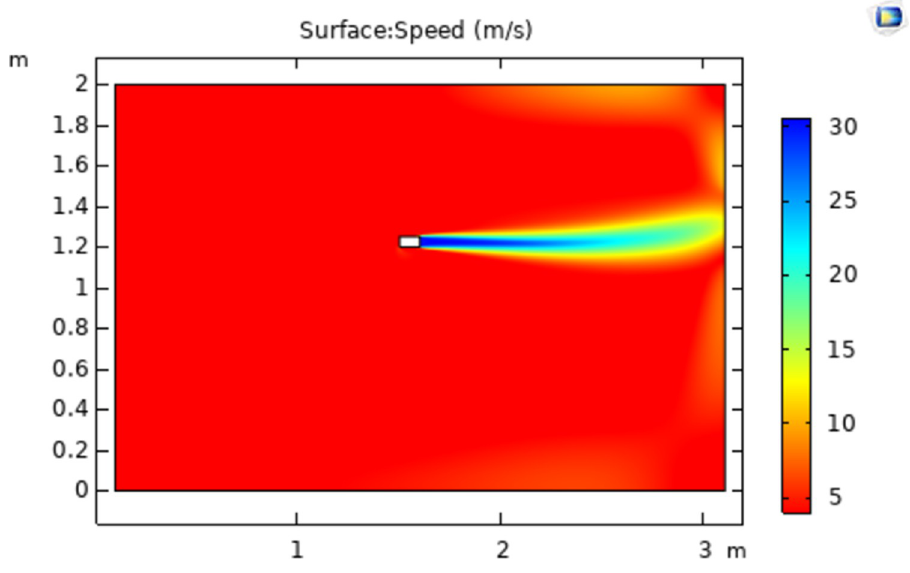
Fig 4. Flow velocity distribution from nozzle no. 1.